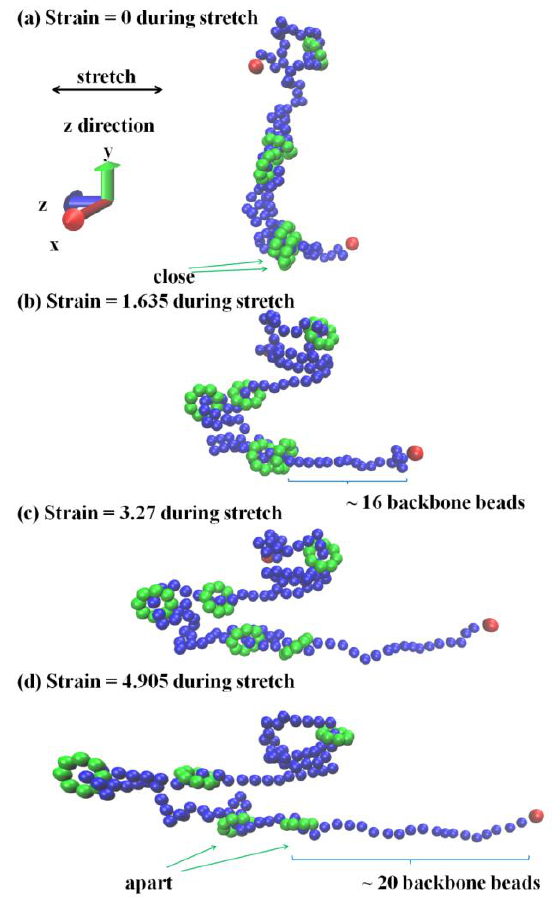
Figure 11. Snapshots of single SR structure corresponding to the different strains in the stretch deformation, monitoring the trajectories and chain sliding.